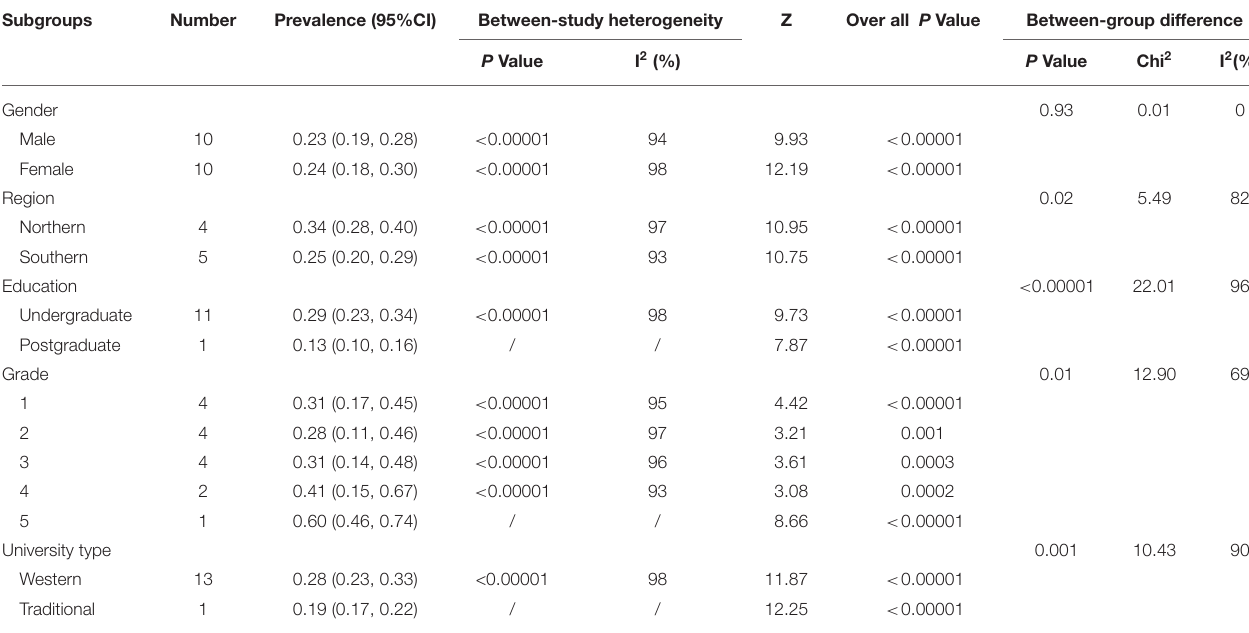
TABLE 2 | Results of the subgroup analysis of sleep problems.